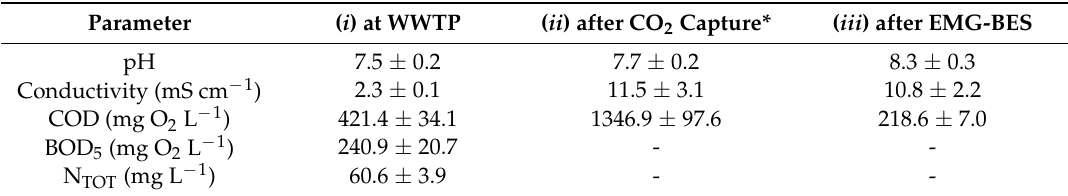
Table A4. Characterization of wastewater used for EMG-BES operation, at three stages: ( i ) as collected at WWTP; ( ii ) after CO 2 capture; and ( iii ) after EMG-BES treatment. Values presented as average ± standard